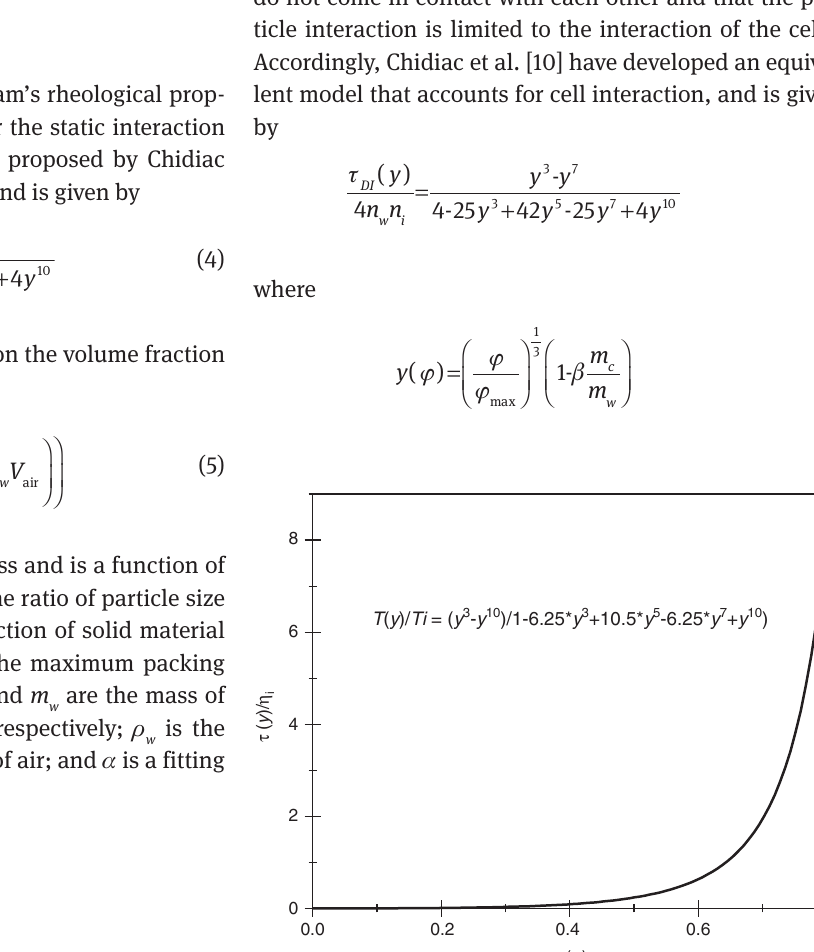
Figure 1: Plot of τ ( y )/ τ